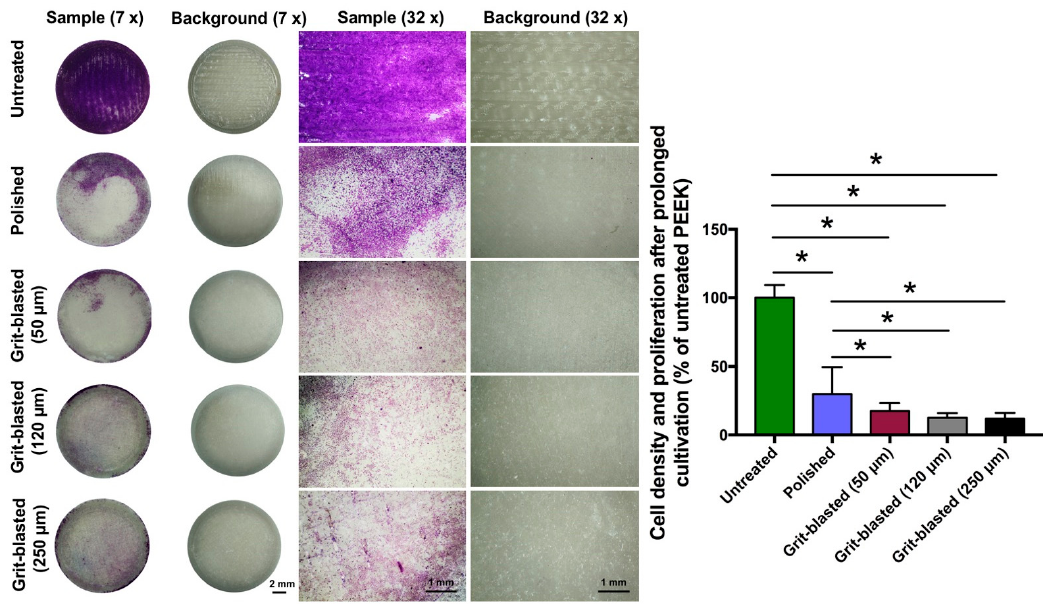
Figure 6. Cell density of SAOS-2 for the di ff erent groups after 5 days of cultivation. Left: overview, mag. 7 × ; right: detail, mag. 32 × . The bar chart shows the relative absorbance of di ff erent groups (normalized by untreated PEEK). The data are presented as means ± standard deviations, * p <